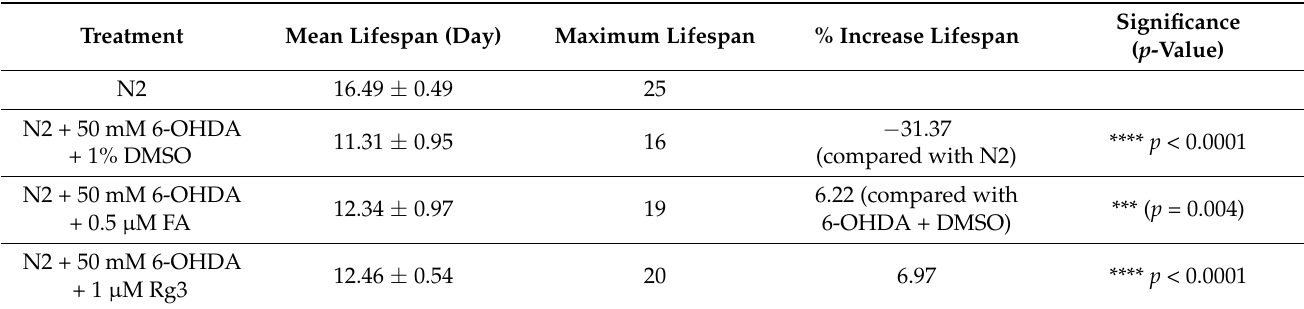
Table 1. Mean lifespan, maximum lifespan, percentage of increase lifespan and significant p values of 6-OHDA-induced N2 worms treated with FA and Rg3.